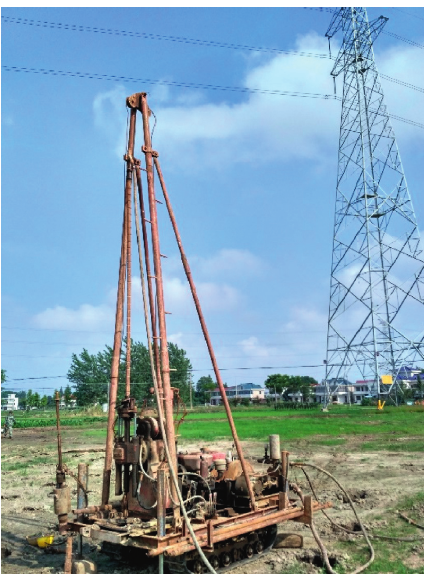
Figure 3: GXY-1C exploration drilling rig and SPT equipment. Table 3: The parameters of GXY-1C exploration drilling rig.